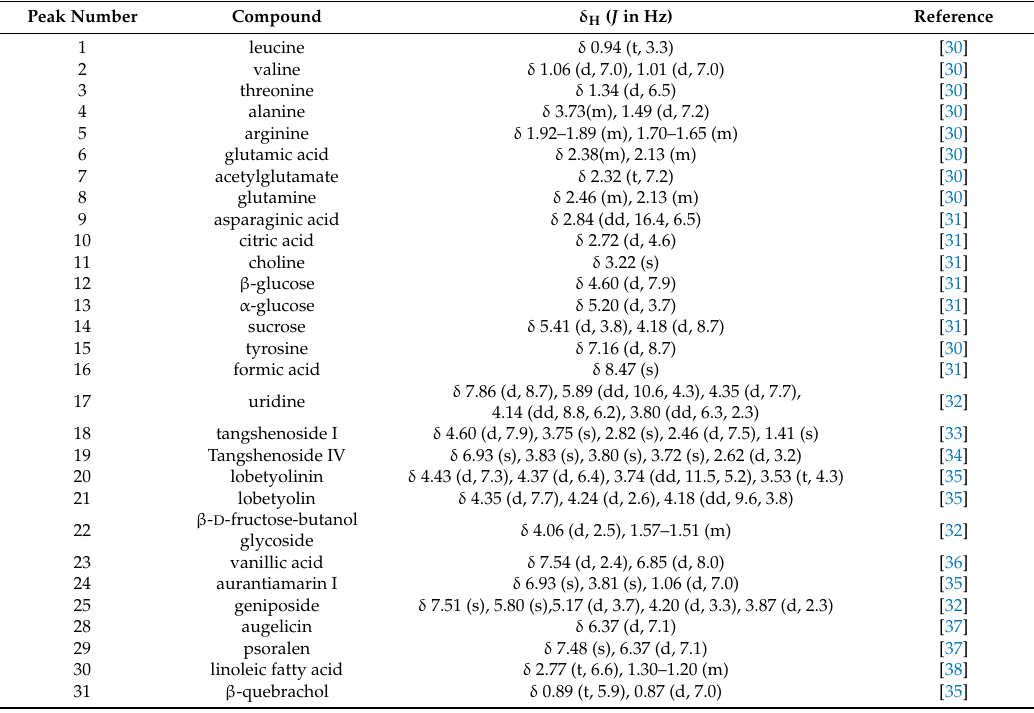
Table 1. Characteristic chemical shifts ( δ in ppm) and coupling constants ( J ) of the compounds detected in the 1 H-NMR of the control- and MeJA-treated adventitious root of C. pilosula . Peak